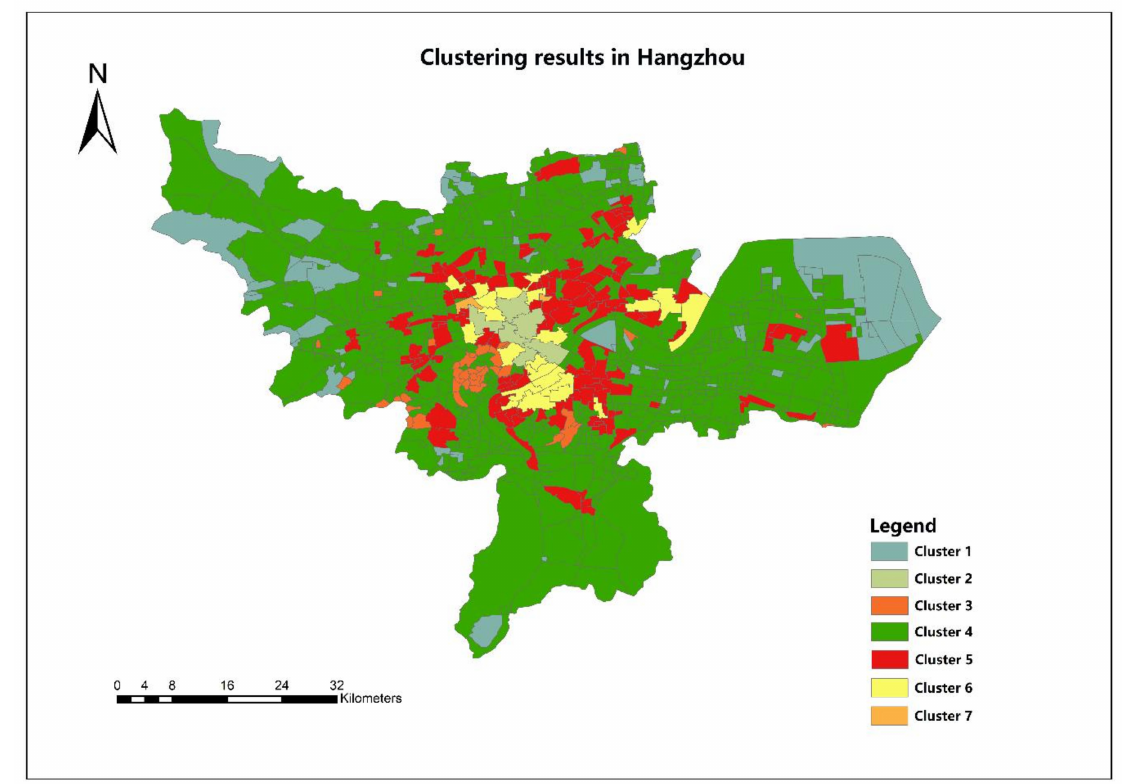
Figure 5. Clustering results for the study area (Hangzhou) obtained at K = 7.